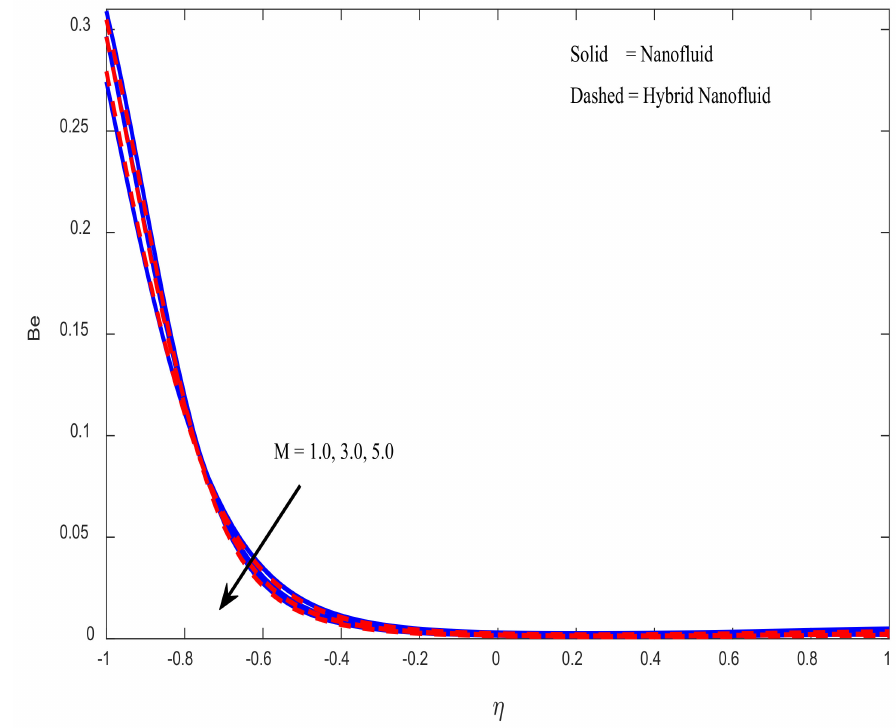
Figure 21. Influence of M on the Bejan number